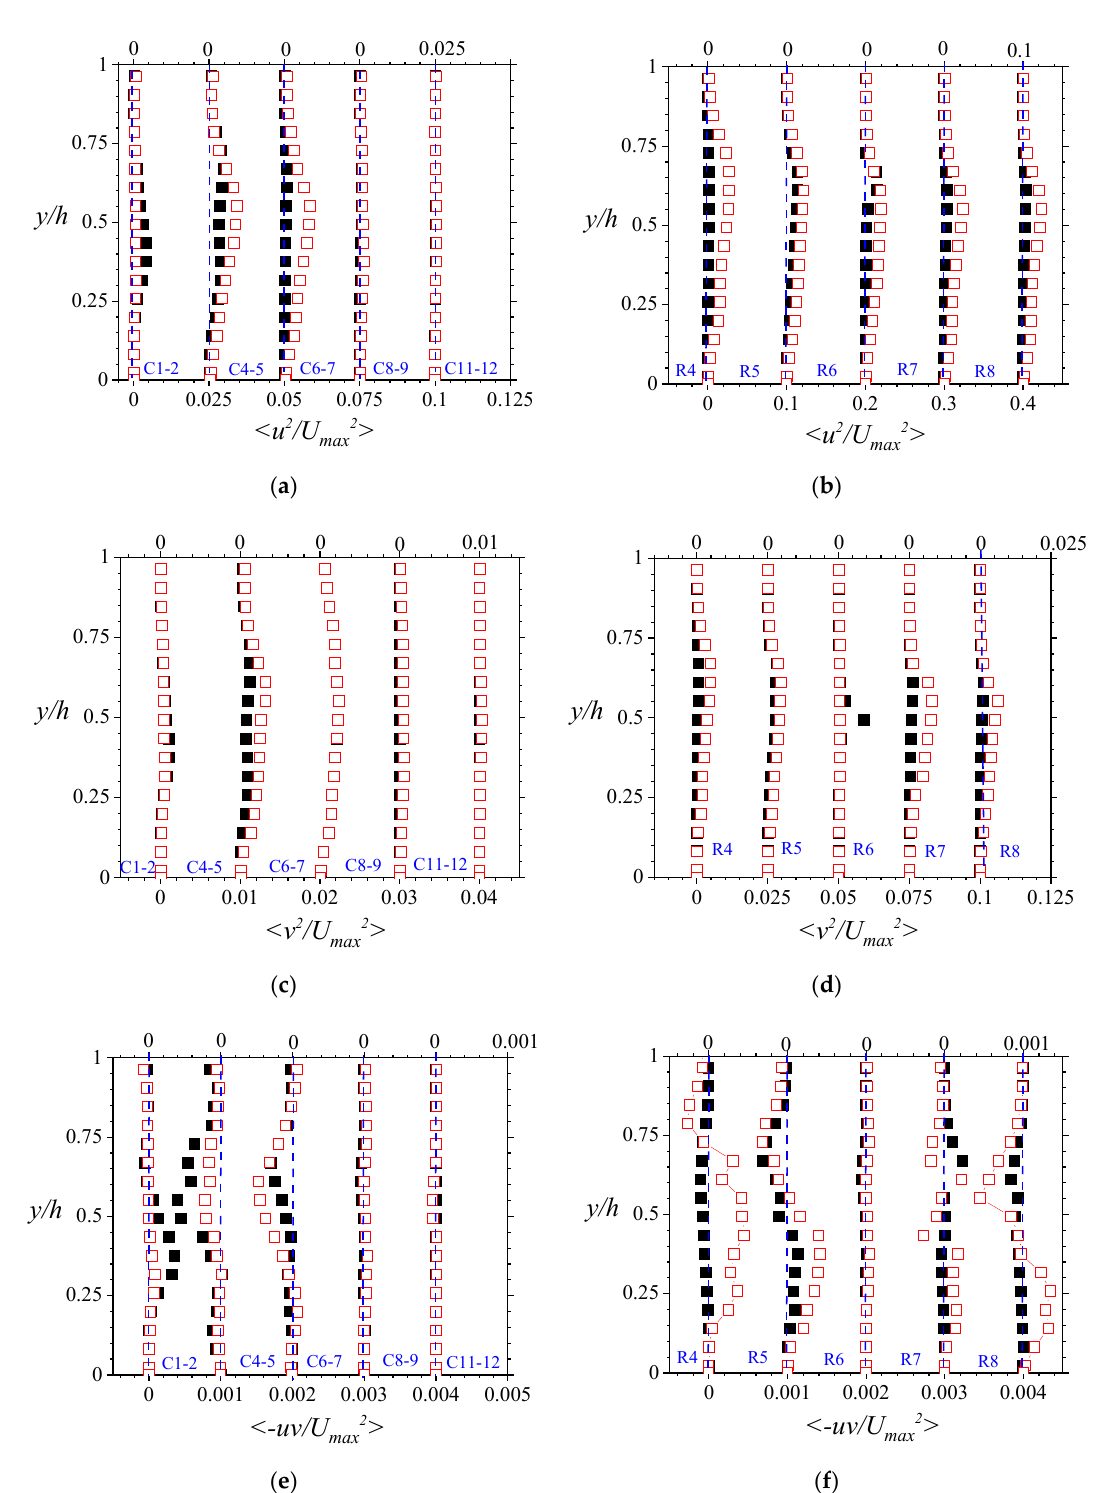
Figure 8. Turbulence quantities < u 2 /U max2 >, < v 2 /U max2 >, and < − uv/U max2 > are respectively line-averaged streamwise Reynolds normal stress, wall-normal Reynolds normal stress, and Reynolds shear stress in the streamwise-wall-normal plane, normalized by the maximum local line-averaged streamwise mean velocity in both open and porous regions. Here, the profiles for the flow within the porous medium are shown. Staggered plots ( a , c , e ) show the streamwise variations whereas ( b , d , f ) demonstrate the spanwise variations. The denominations C and R respectively stand for columns and rows, and are illustrated in Figure 1. Black-filled boxes are the results for Test A , and red-open boxes are the results for Test B